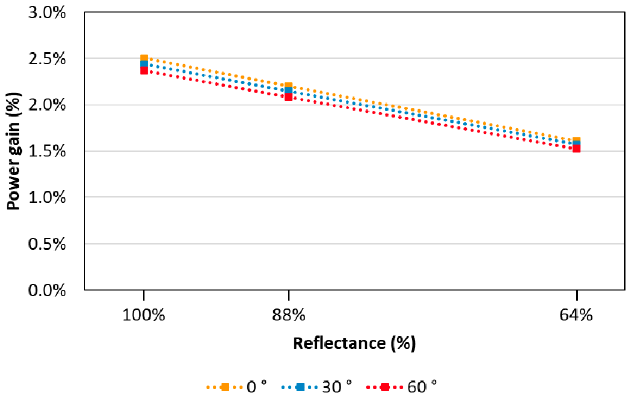
Figure 9. Power gain due to internal reflection for different reflectivities of the mesh.